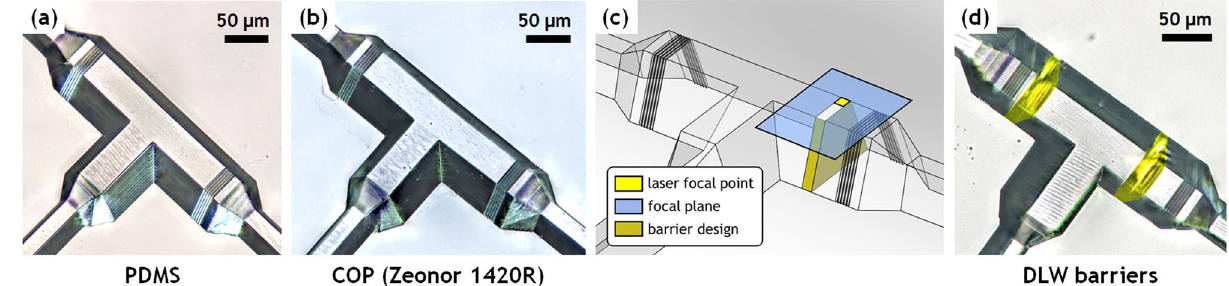
Figure 5. ( a ) PDMS positive mold used to pattern COP, and ( b ) negative COP substrate produced via hot embossing from the PDMS intermediate mold. ( c ) Illustration of the in-channel DLW process, with printing beginning at the top surface, furthest from the inverted objective lens, to avoid the need for focusing through any pre-printed structures. ( d ) A typical COP device with two DLW barriers. The barriers are false colored for